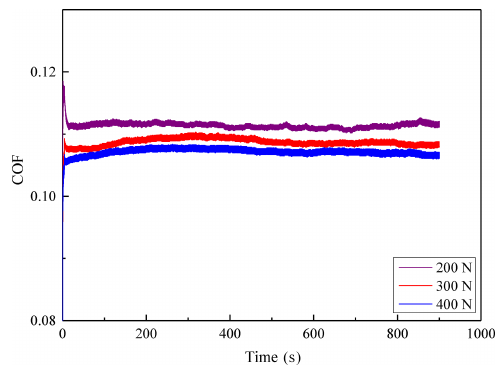
Figure 9. The COF and surface roughness under different lubrica- tion